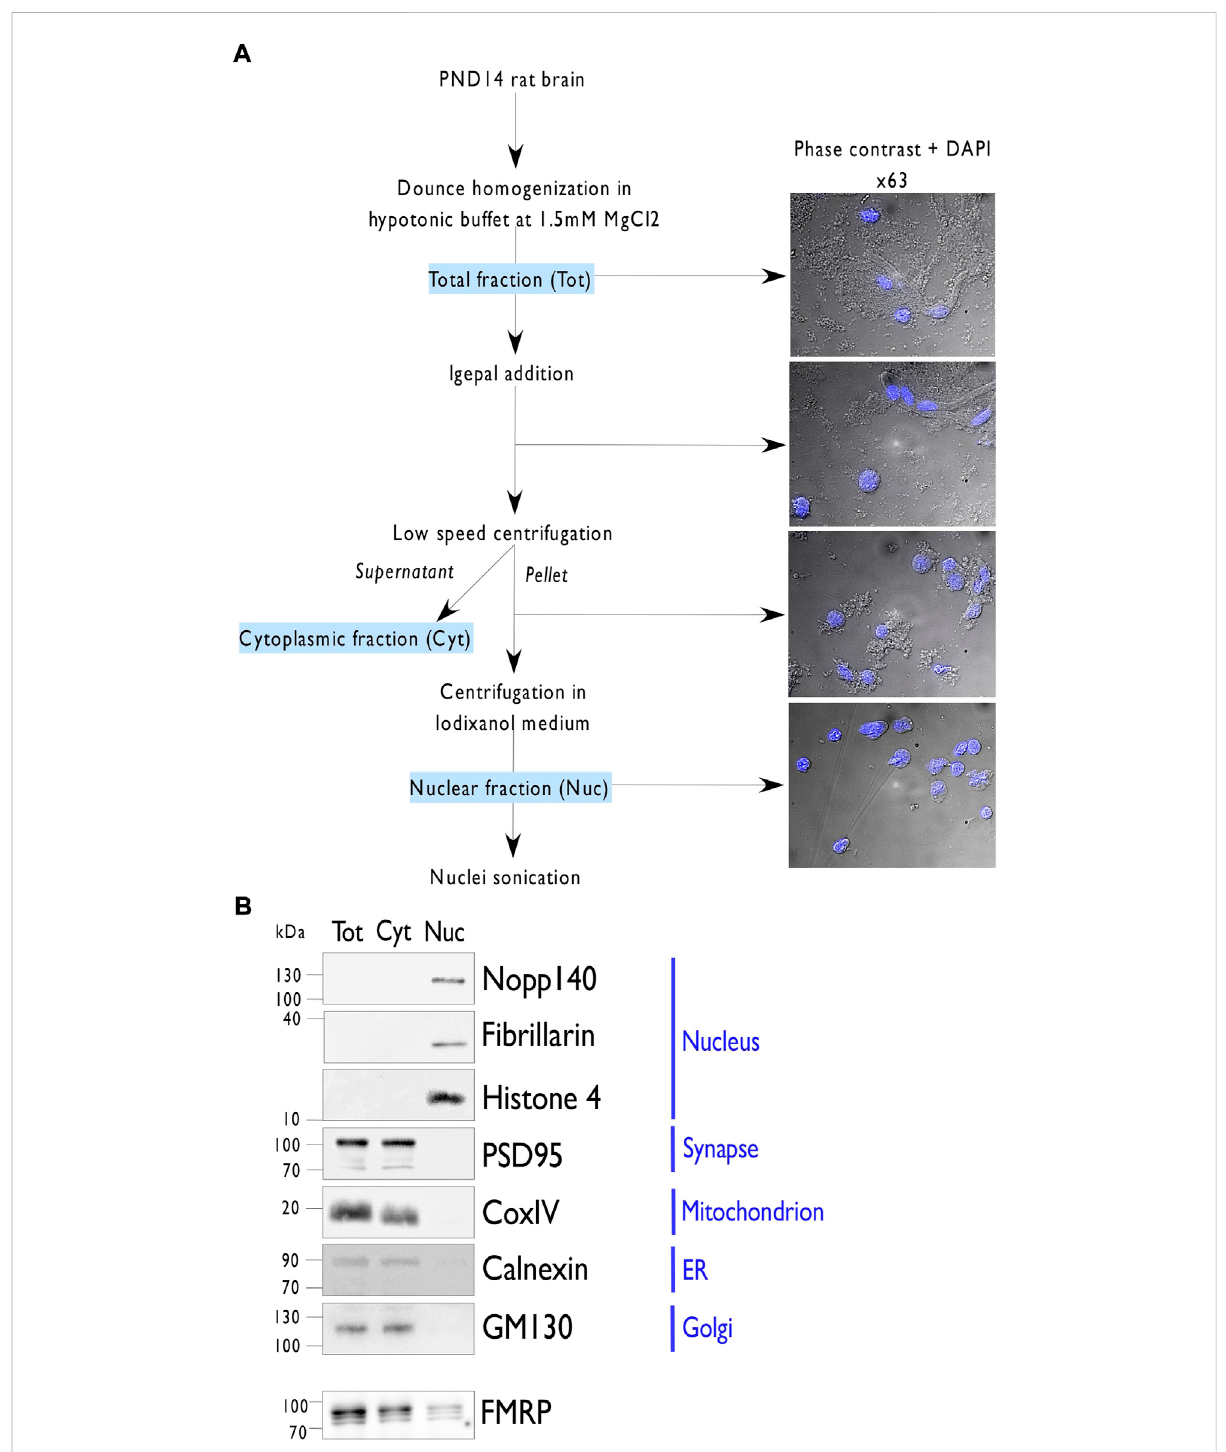
Nuclei isolation from PND14 rat forebrains. (A) . Representation of the protocol used to purify nuclei from postnatal day 14 (PND) rat forebrains. Brie fl y, forebrains were dounced in hypotonic buffer and then supplemented with 0.3% of Igepal detergent. After fi ltration, the total forebrain lysate (Tot) was subjected to low-speed centrifugation to separate the nuclei in the pellet from the cytoplasmic material in the supernatant (Cyt). After resuspensionof the pellet in hypotonic buffer, 1.1 volume ofOptiprep was added. After gentle homogenization, themix was subjected to high- speed centrifugation and the puri fi ed nuclei (Nuc) were recovered in the pellet. To extract nuclear proteins, puri fi ed nuclei were resuspended in a native lysis buffer, sonicated, and clari fi ed by high-speed centrifugation. To follow the purity fraction, images are acquired by phase contrast and superposition with DAPI staining at the indicated steps. (B) . Immunoblot analysis of 10 µg of proteins from the indicated fractions (Tot, Cyt, Nuc) per lane and detected by western blotting using antibodies against different subcellular markers or